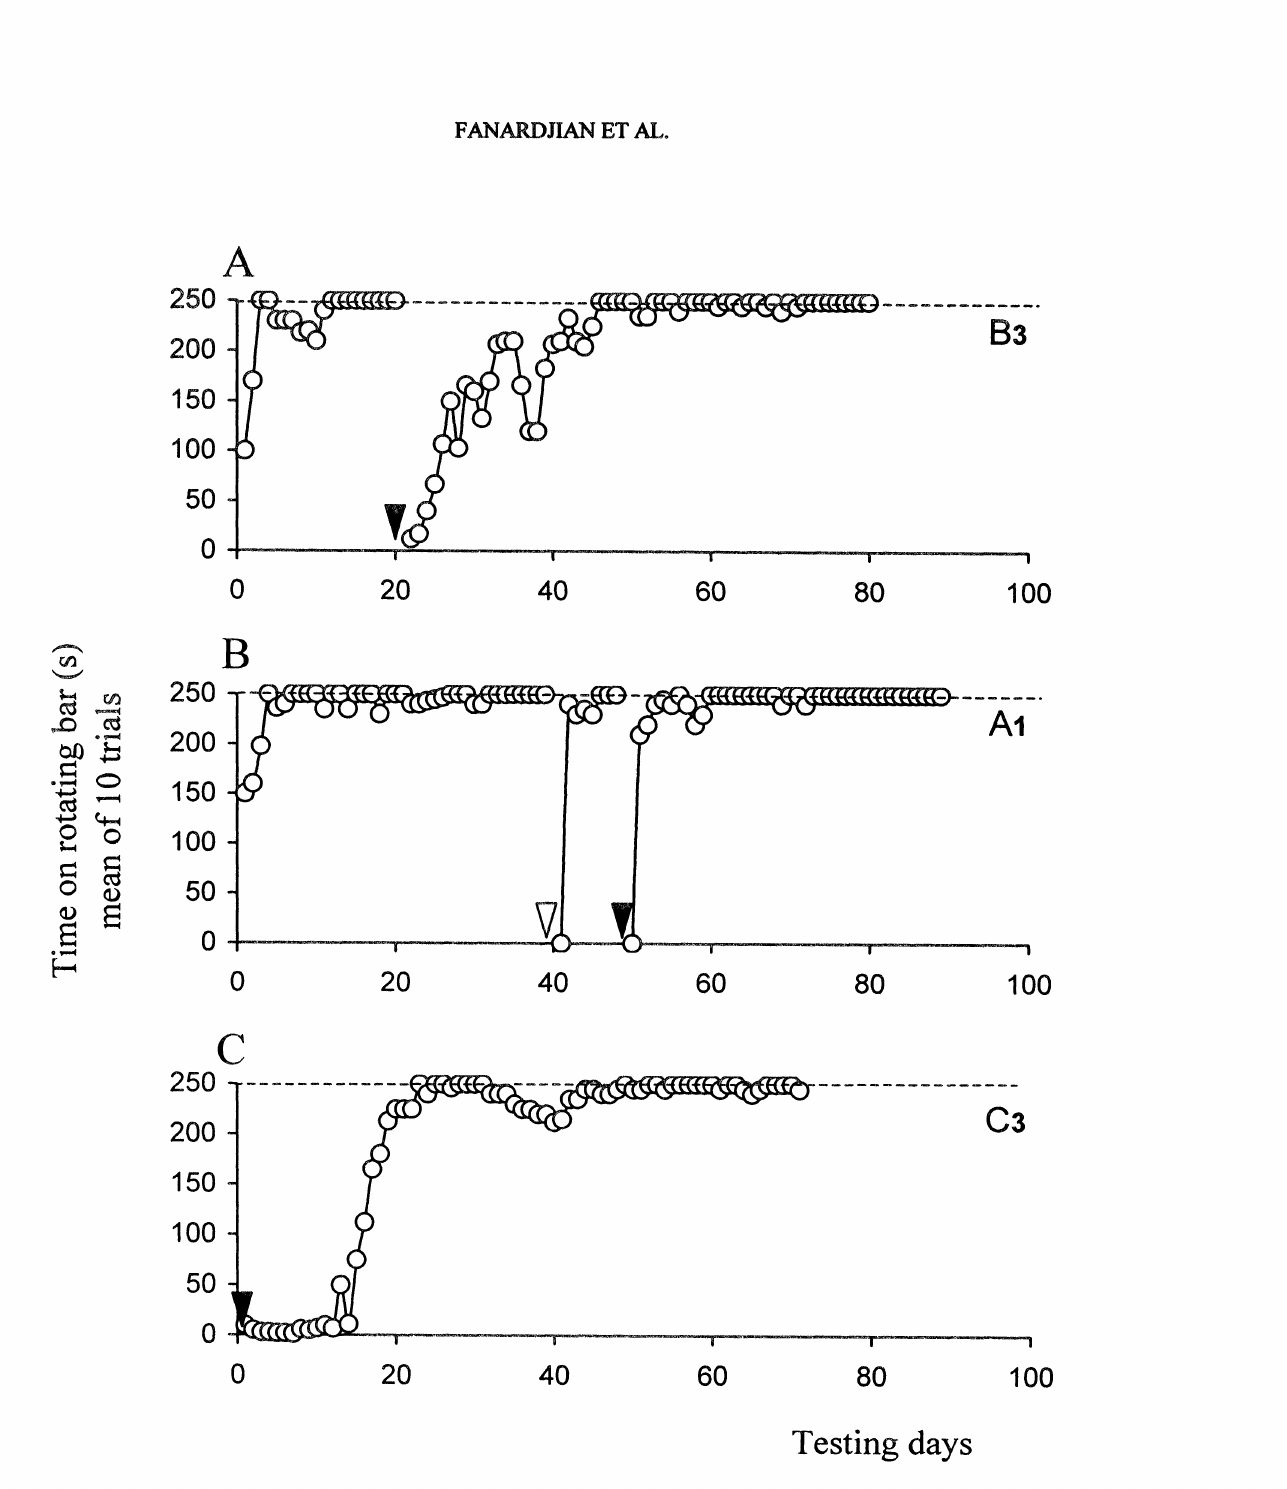
Fig, 5: Effects of unilateral transection of the bulbar pyramid and ablation of the ipsilateral sensorimotor cortex on the performance of instntmental reflexes in three rats. The insLrnental reflexes were trained before (A, B) or after (C) these lesions. (A, C) Sensorimotor cortex alone was ablated. (B) Sensorimotor cortex was ablated after transection of the pyramid. The progression ofreflexes is shown in days (abscissa). The mean value (in seconds) of 10 trials on the rotating bar is plotted for each training day (ordinate). The dashed line is the 250-s criterion level of performance. The open arrowhead designates the day of pyramid transection; the dosed arrowhead indicates the day of sensorimotor cortex ablation. Letter and numerals indicate rat series and